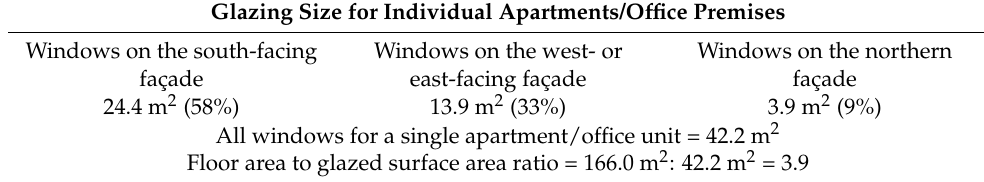
Table 4. Listing of window surfaces for each of the building’s orientations. Glazing Size for Individual Apartments/Office